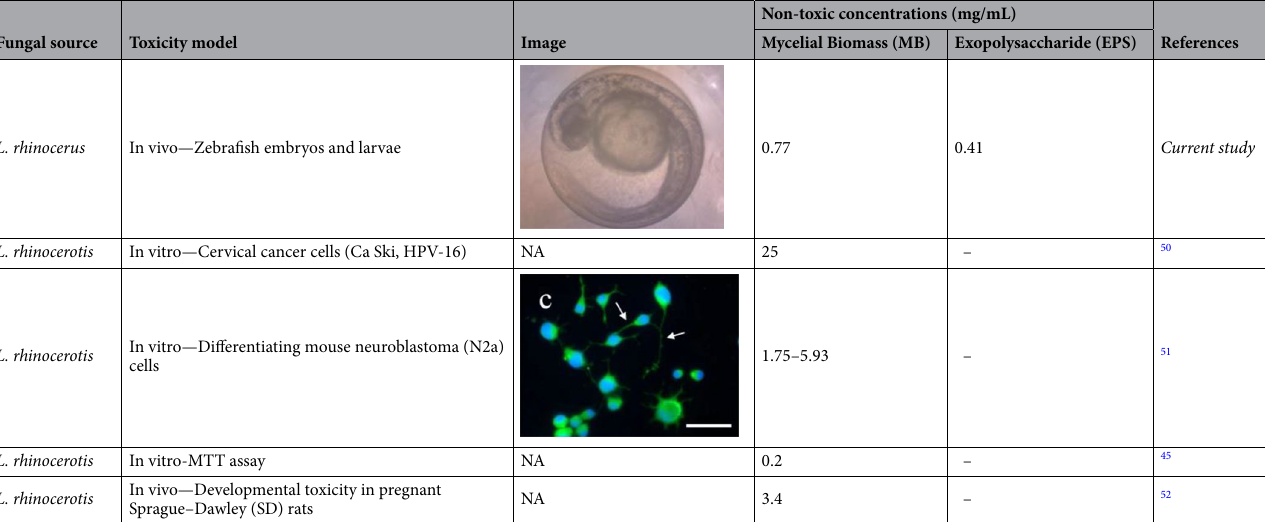
Table 1. Similarity with literature for non-toxicity evaluation of mycelium biomass (MB) and exopolysaccharide (EPS) from the rare Tiger milk mushroom Lignosus sp. [NA: Not